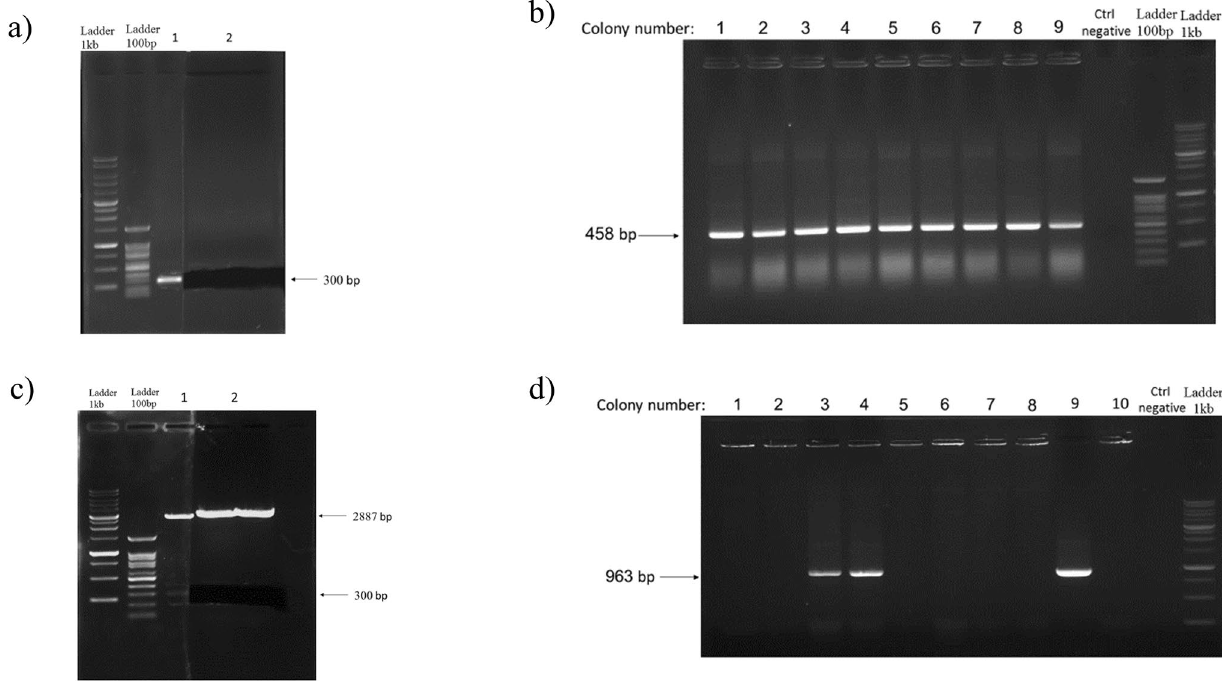
Figure 6. Plasmid construction of hsa-miR-30c. ( a ) Gel extraction of amplified hsa-miR-30c by agarose gel electrophoresis, lane 1: detector for gel extraction and lane2: Gel extraction of hsa-miR-30c PCR fragments. ( b ) PCR colony for the recombinant pTZ57R/T vector, 1 to 9 colonies were positive. ( c ) Gel extraction of hsa-miR- 30c, which was double digested from the pTZ57R/T vector by agarose gel electrophoresis, lane 1: detector for gel extraction and lane2: fragments of the digested vector. ( d ) PCR colony for the recombinant pBud-EGFP plasmid, the 3, 4, 9 colonies were the positive colony PCR of the pBud-EGFP plasmid. The high resolution figures of the electrophoretic gels are provided as Supplementary Fig.